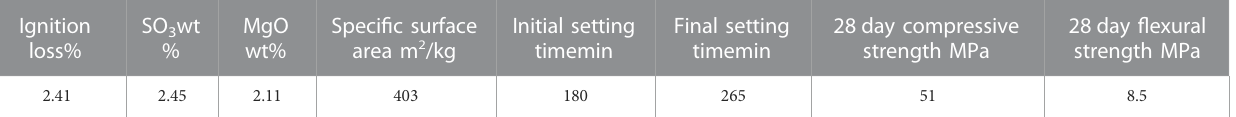
TABLE 1 Basic indexes of PO 42.5ordinary Portland cement.